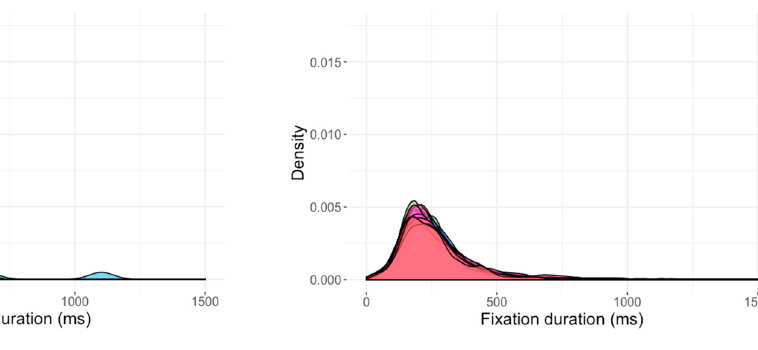
Figure 8. The distributions of saccades’ latency for each image in the dataset. On the left: only initial saccades (16–19 data points for each image). On the right: all saccades (542–794 data points for each image, mean number 661). Both plots show that latencies of saccades, which are related to only one image, nonetheless tend to produce a right-skewed distribution, typical for any RT distribution.